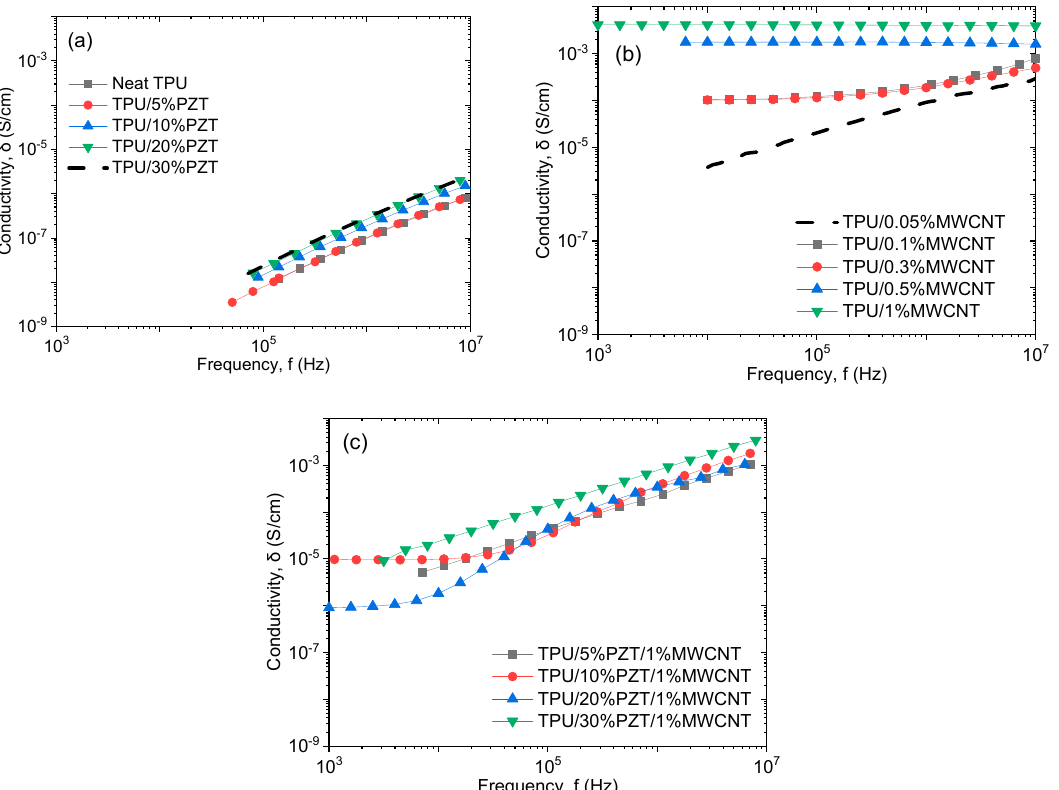
Figure4. Broadbandelectricalconductivityasafunctionoffrequencyfor( a )TPU / PZT,( b )TPU / MWCNT, Figure 4. Broadband electrical conductivity as a function of frequency for ( a ) TPU/PZT, ( b ) and ( c ) TPU / PZT / 1 vol% MWCNT TPU/MWCNT, and ( c ) TPU/PZT/1 vol% MWCNT composites.